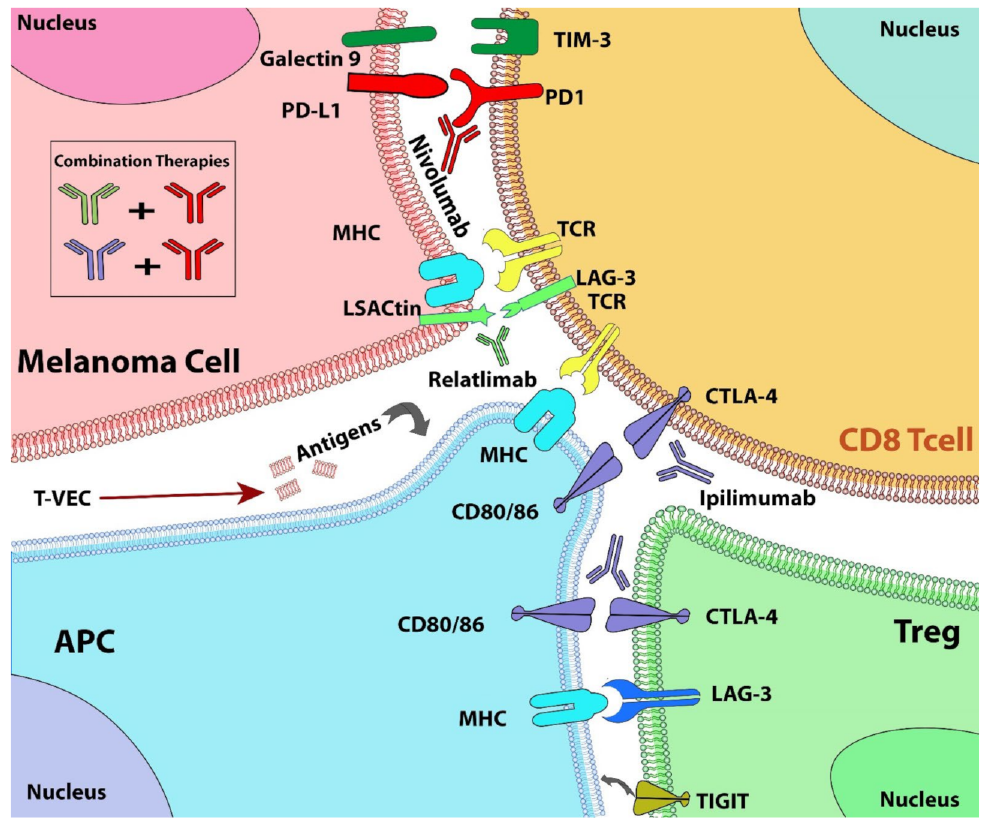
Figure 3. Combination of various immune checkpoint inhibitors. Combinations of immunotherapies, such as PD-1/PD-L1 antibodies, e.g., nivolumab and anti-CTLA-4 inhibitors, e.g., ipilimumab, have been shown to improve survival rates in melanoma patients. The addition of ipilimumab to the nivolumab regimen increases the infiltration of CD8-positive cells in the tumor. Another recently approved combination of LAG3 inhibitor relatlimab with nivolumab increases activation of CD4+ and CD8+ T cells, and Tregs, resulting in antitumor